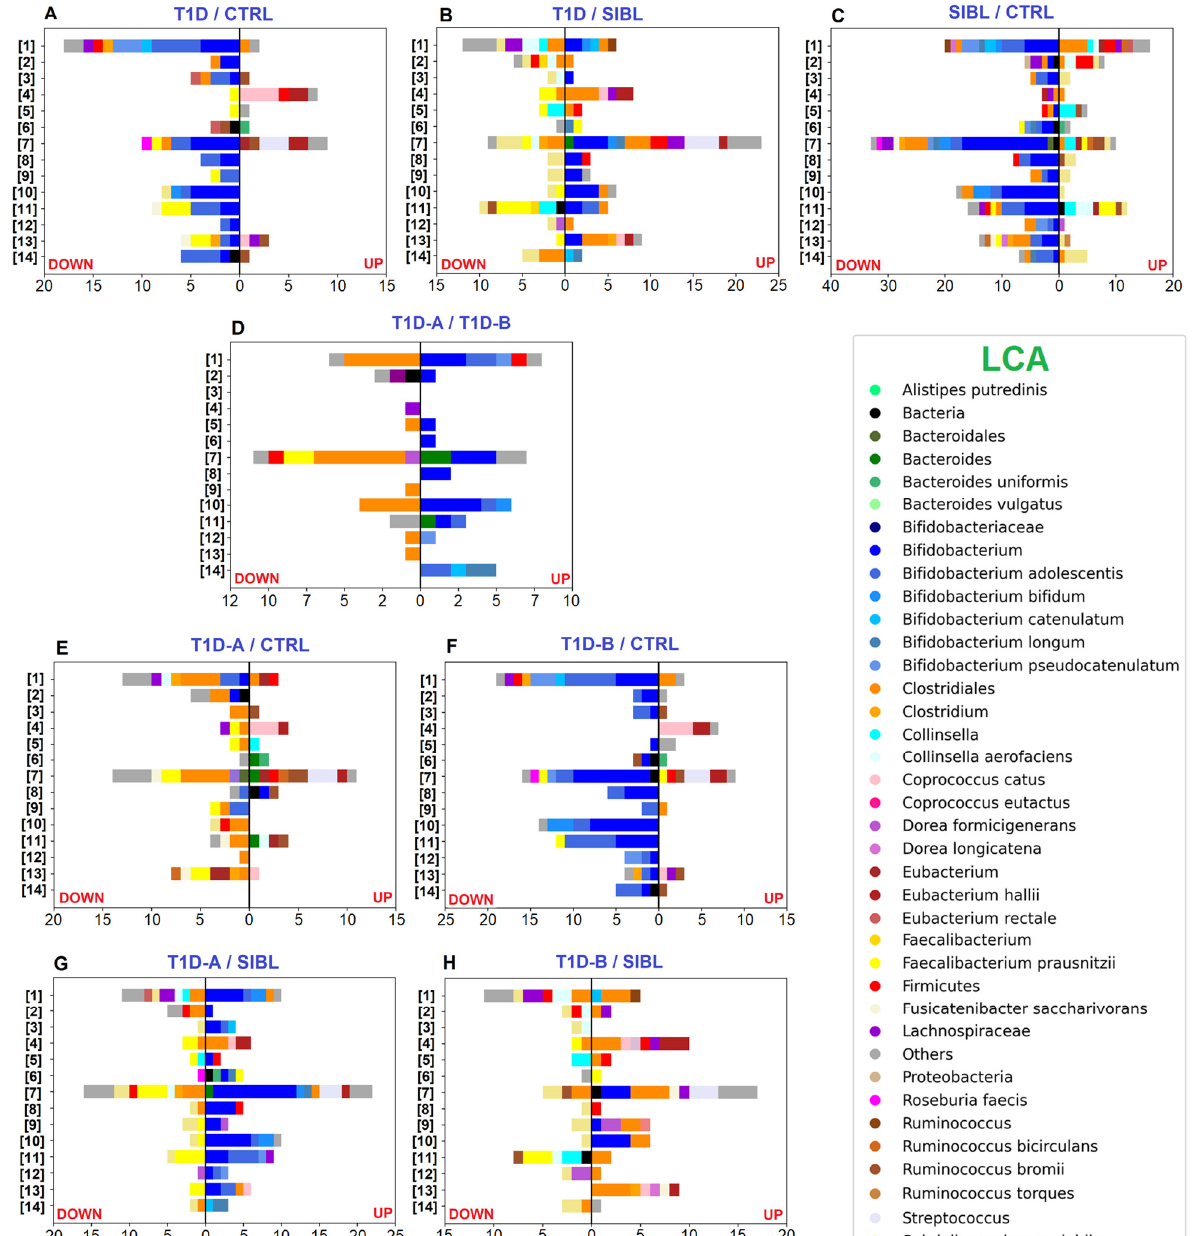
groups versus CTRL. Panels ( G , H ): tests comparing T1D-A and T1D-B groups versus SIBL.